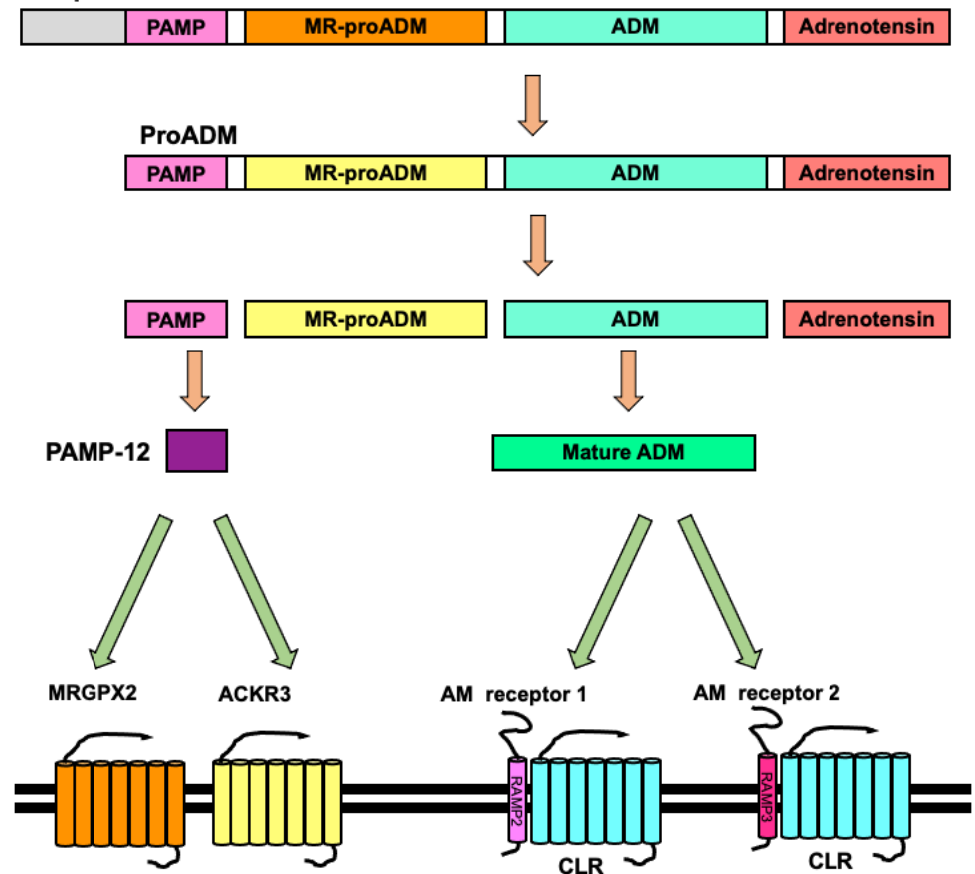
Figure 2. Adrenomedullin (ADM), pro-adrenomedullin N-terminal 20 peptide (PAMP), and receptors of ADM and PAMP. The cleavage of preproADM and the release of the signal peptide produce proADM. The cleavage of proADM generates mid-regional proadrenomedullin (MR-proADM), ADM, and adrenotensin. Immature ADM is converted into mature CT by post-transcriptional mod- ifications (disulfide bridge between Cys 16 and Cys 21 and amidation of C-terminus) and binds to ADM receptors AM receptor 1 and AM receptor 2. PAMP is converted into PAMP-12, which binds to Mas-related G-protein coupled receptor member X2 (MRGPRX2 in humans and Mrgx2 in mice) and atypical chemokine receptor 3 (ACKR3).